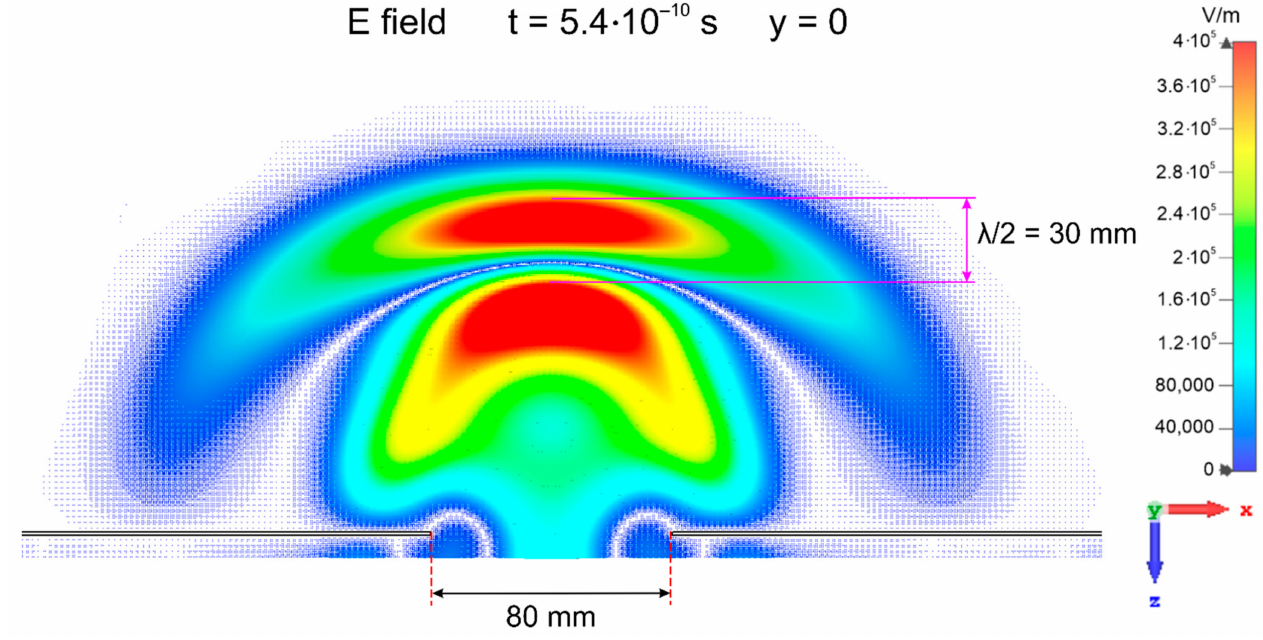
Figure 7. The electric field strength amplitude in the x–z plane for y = 0 at t = 0.54 ns near the front wall is